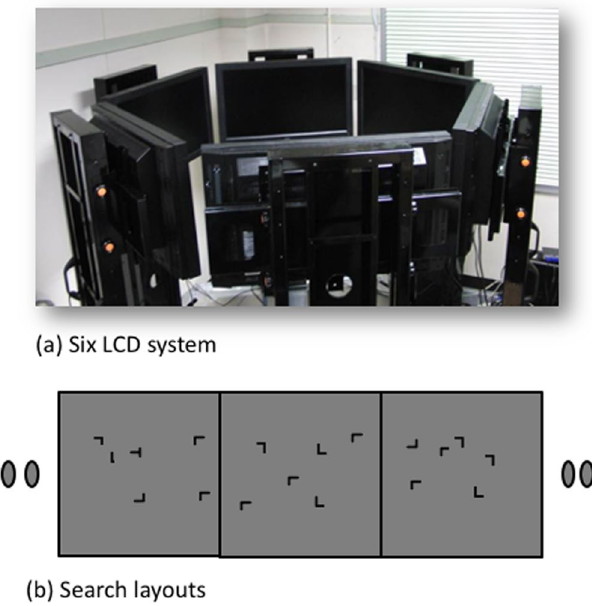
Figure 1. ( a ) Experimental setup. Six LCDs were arranged to surround the observer. One target (“T”) and 35 distractors (“L”) were presented on the six displays. ( b ) Stimulus display. Stimulus letters were arranged randomly with restriction that the number of the letters on each display was kept constant as six (six Ls or five Ls with a T). The locations of items were chosen randomly from intersections of an invisible 12 × 8 grid on each